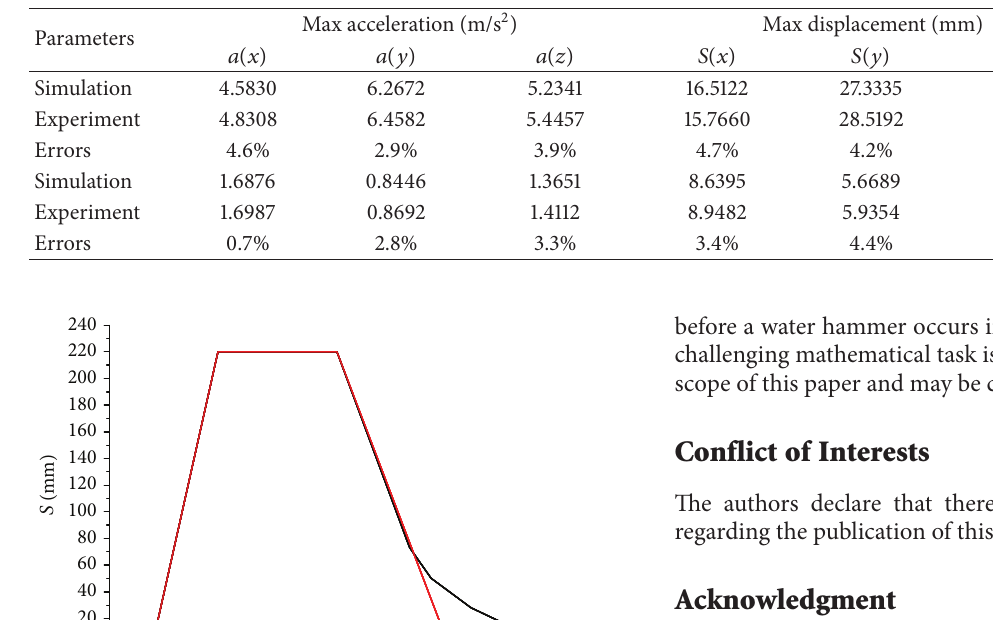
Table 4: Results comparison of simulation and experiment.